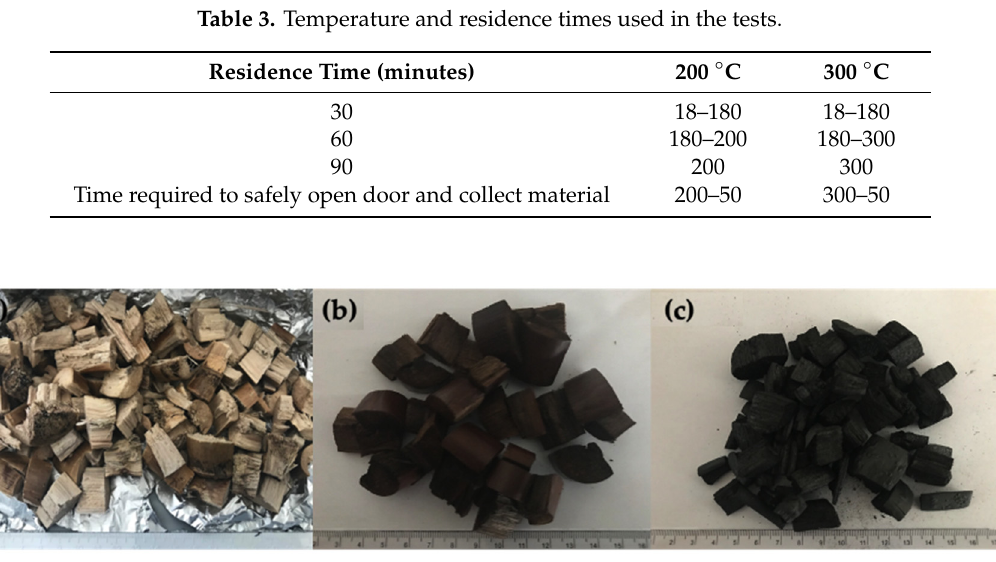
Figure 4. Obtained materials: ( a ) after drying; ( b ) after torrefaction at 200 °C; and ( c ) after torrefaction at 300 °C.